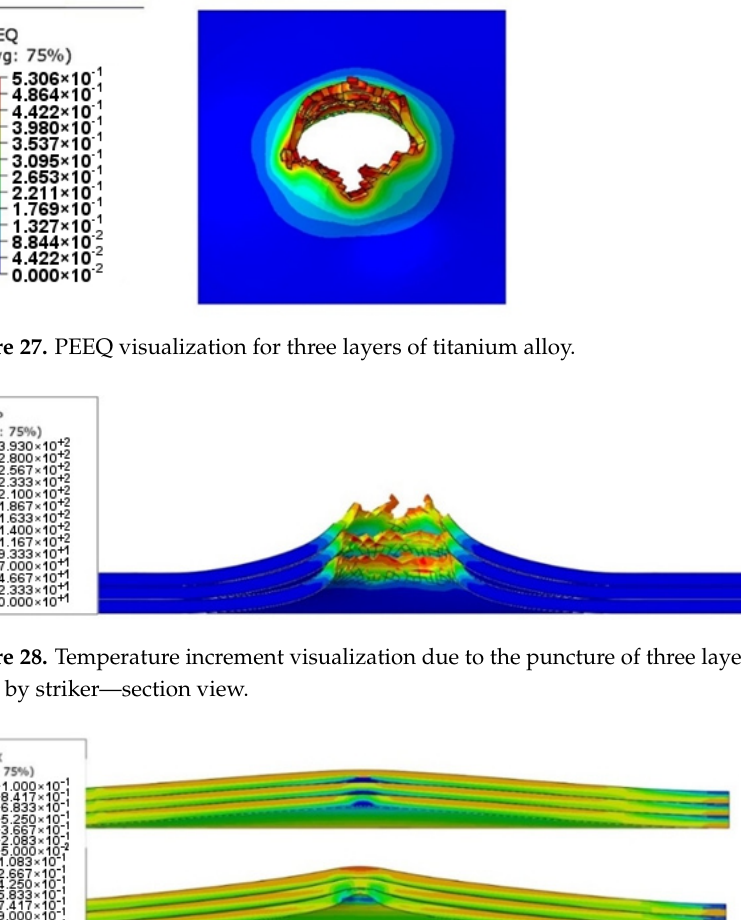
Figure 26. HMH stress visualization for three layers of titanium alloy.